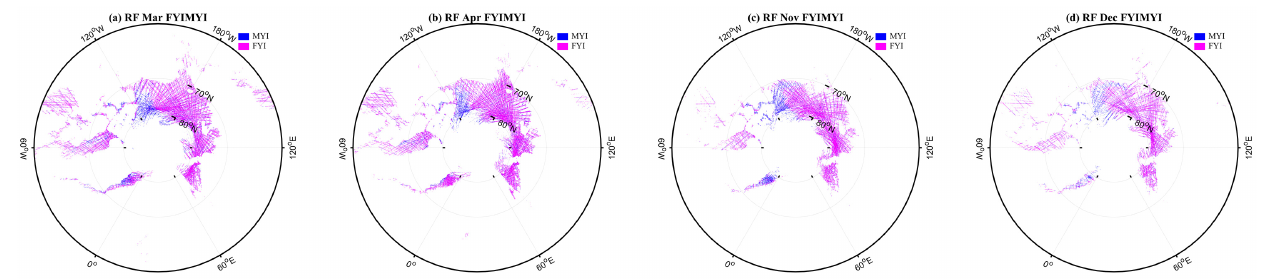
Remote Sens. 2021 , 13 , x FOR PEER REVIEW Figure A11. RF for FYI-MYI classification using the data in February as the training set. The data in ( a ) March, ( b ) April, ( c ) November, and ( d ) December are used as the test set in turn.